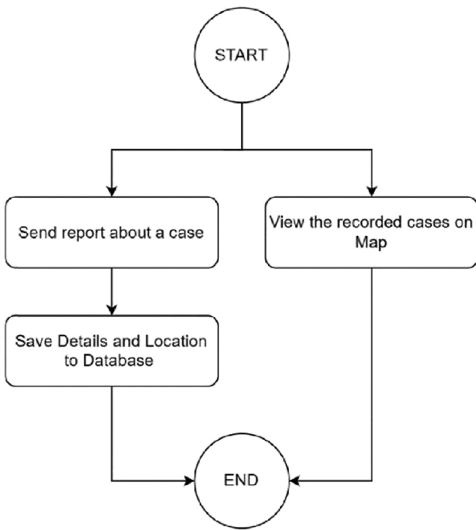
Figure 6: Mobile app process fl